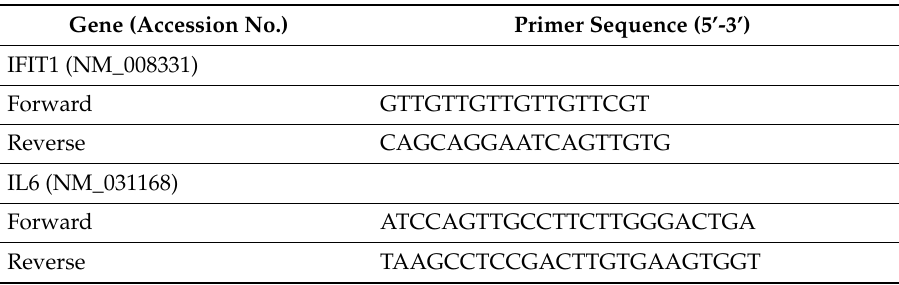
Table 1. Primer sequences used for